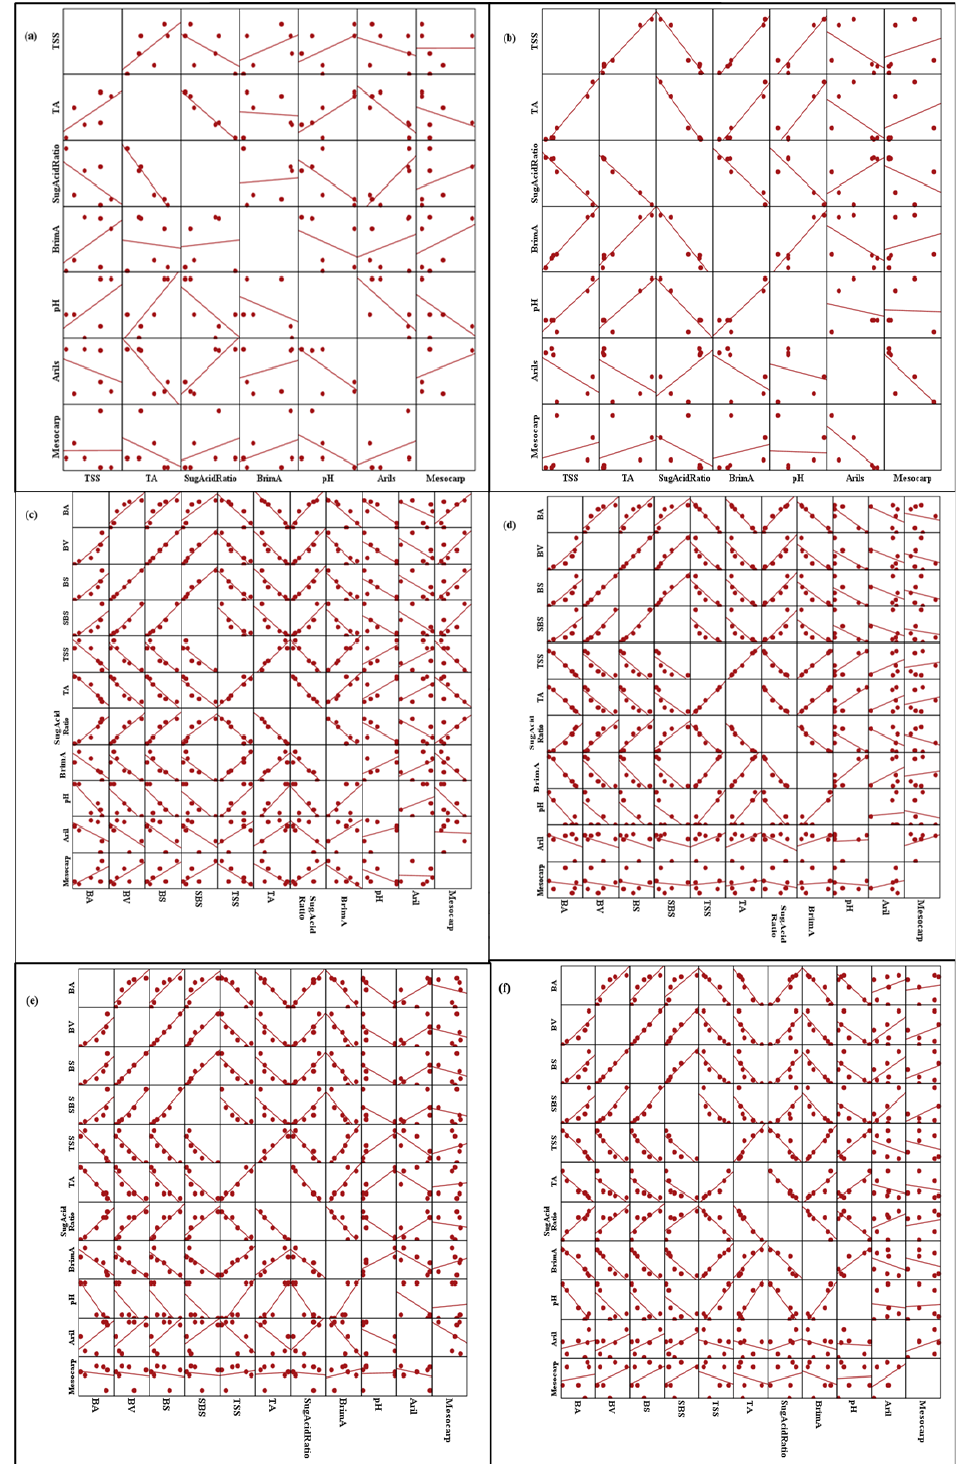
Figure 7. The correlation between resulting parameters of the non-bruised, low-impact (45°; 1.18 J), and high-impact (65°; 2.29 J) bruised pomegranate fruit over 28 days of storage at 5 °C and 22 °C using a scatter plot matrix.